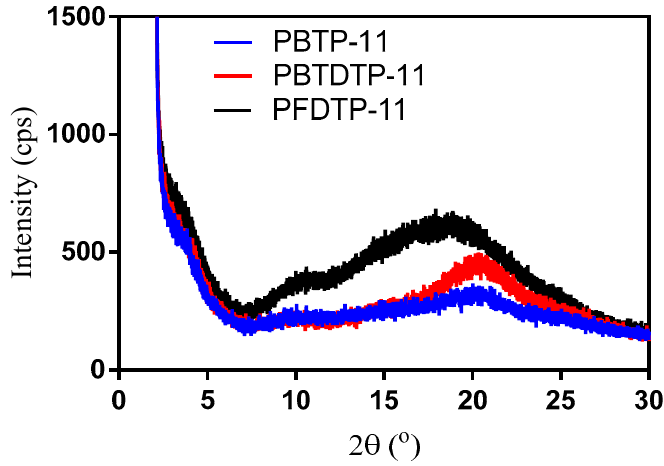
Figure 4. The powder XRD of PBTP-11, PBTDTP-11 and PFDTP-11.